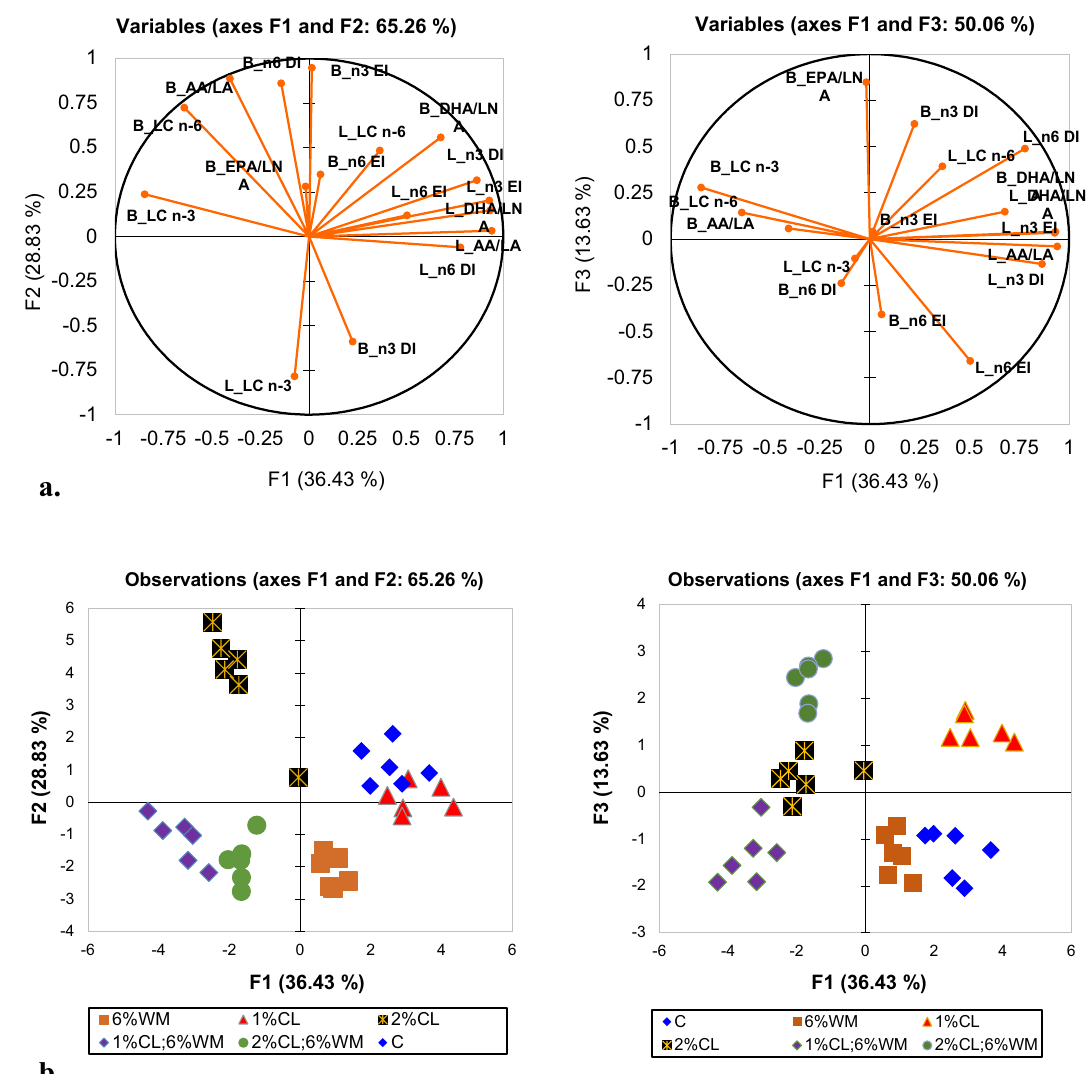
Figure 1. ( a ) The correlation circle represents the projection of considered variables in the factors space. ( b ) The distribution of the samples in the factor space. The variables considered were: elongation and desaturation indices for n-3 and n-6 FA series, long-chain FA n-3 and n-6 series, and efficiency of conversion: DHA/LNA, EPA/LNA, and AA/LA. The parameters notation was preceded by “L” or “B” corresponding to “liver” or “breast”